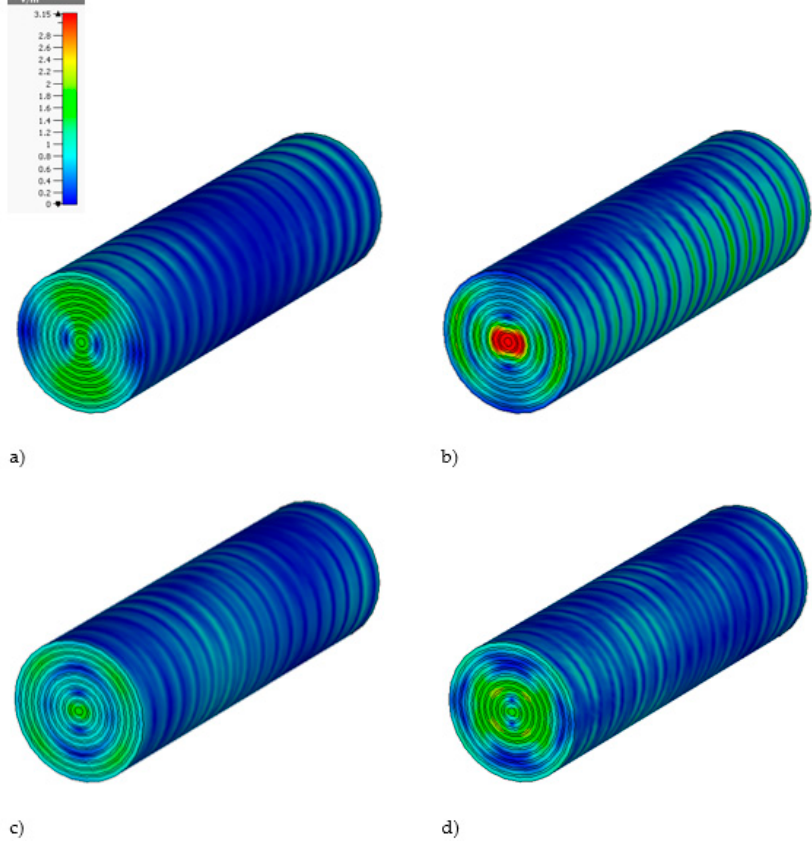
Figure 2. Electric field distribution inside dry poplar. ( a ) f = 2.45 GHz 50% permittivity variation; ( b ) f = 3 GHz 50% permittivity variation; ( c ) f = 2.45 GHz 100% permittivity variation; and ( d ) f = 3 GHz 100% permittivity variation.